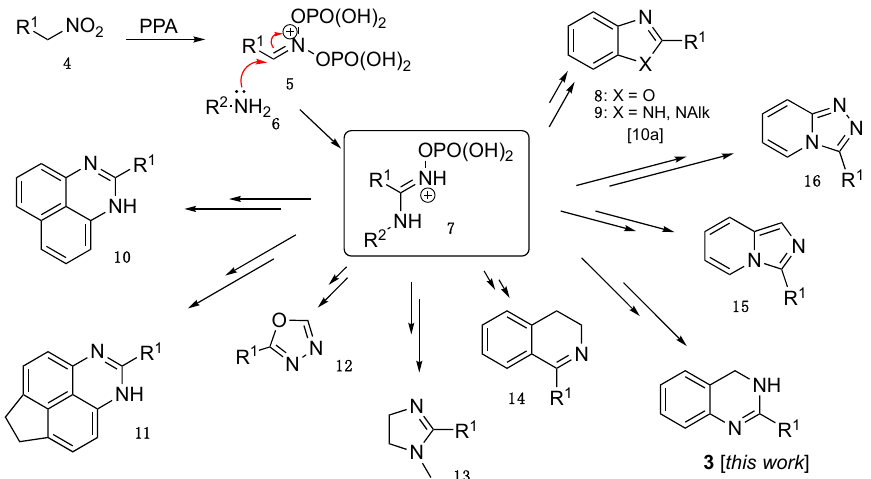
Scheme 2. Synthesis of nitrogen-based heterocycles employing electrophilically activated nitroal- kanes.